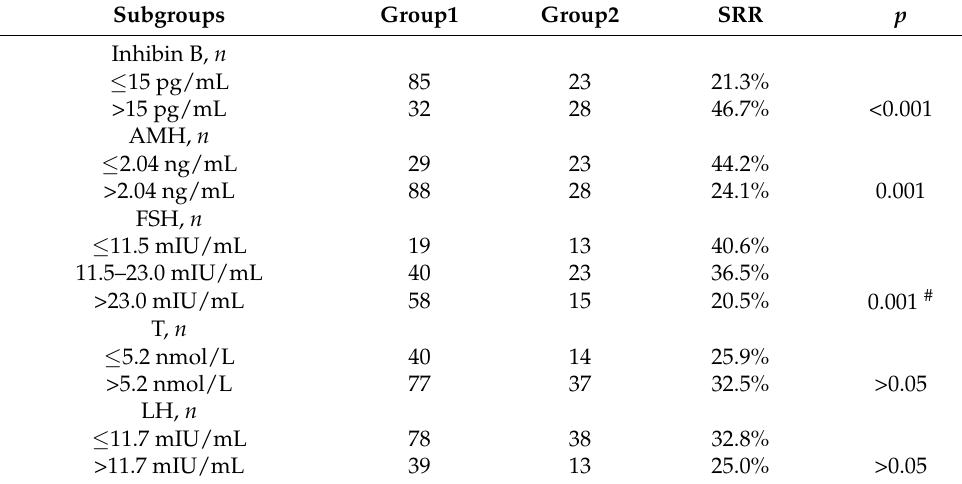
Table 2. Comparison of SRR between two groups.